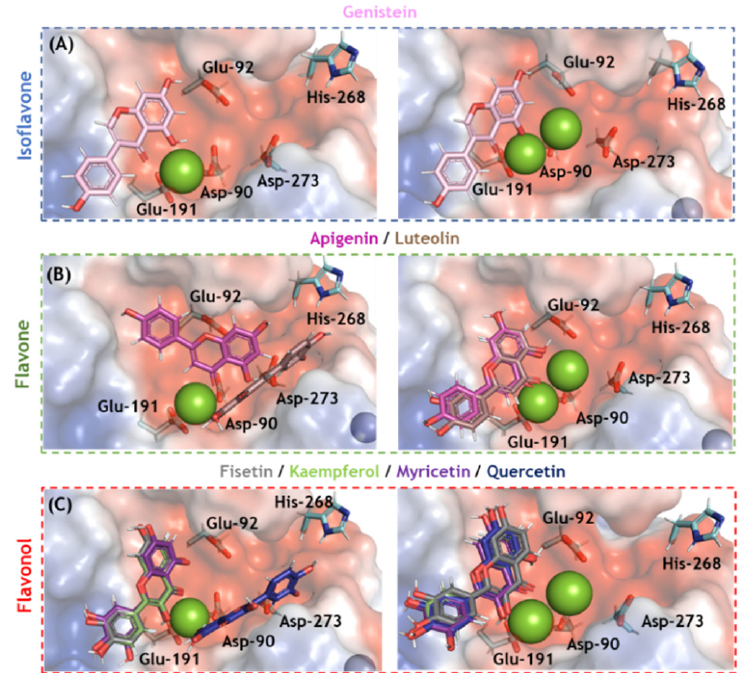
Figure 4. The electrostatic potential map ( − 68.065 and +68.065 a.u, in red and blue, respectively) of